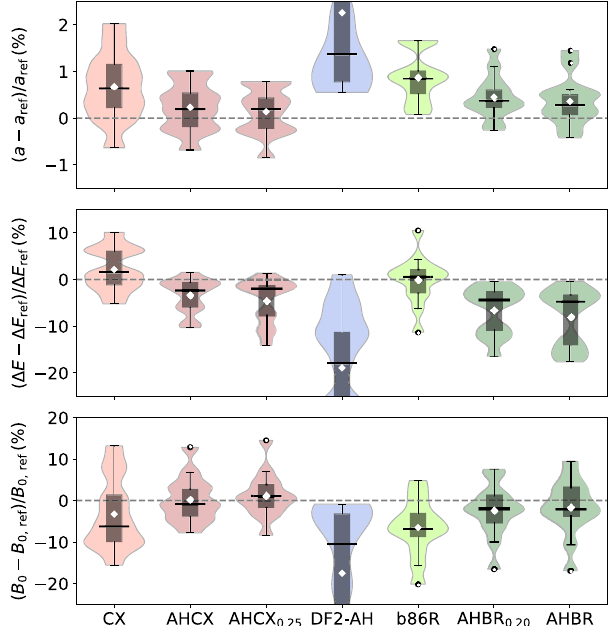
FIG. 4. Bulk-system performance as asserted in percentage deviations for the CX-AHCX and B86R-AHBR descriptions of lattice constants a , bulk cohesive energies E , and bulk moduli coh B 0 . We also show the impact of setting the Fock-exchange mixing. The default AHCX and AHBR mixing value is set at 0.20 and 0.25, respectively, while a subscript identifies an adjustment. For completeness, we furthermore include a performance assess- ment for DF2-AH, the RSH form of vdW-DF2 that is implicitly defined by analysis in Ref. [17]. We compare our results (listed in the Supplemental Material [62]) computed in the Born- Oppenheimer approximation, with experimental values (back- corrected for vibrational effects) [55]. The violin plots summarize result-statistics data for 13 solids (five transition metals, one simple metal, four semiconductors, and three ionic insulators), with the CX and AHCX results repeated from Ref. [17]. The set of horizontal bars (of diamonds) reflects the mean (median) deviation in the distributions, while the boxes identify the so- called interquartile range; see text. Outliers (identified in the text) are shown by open